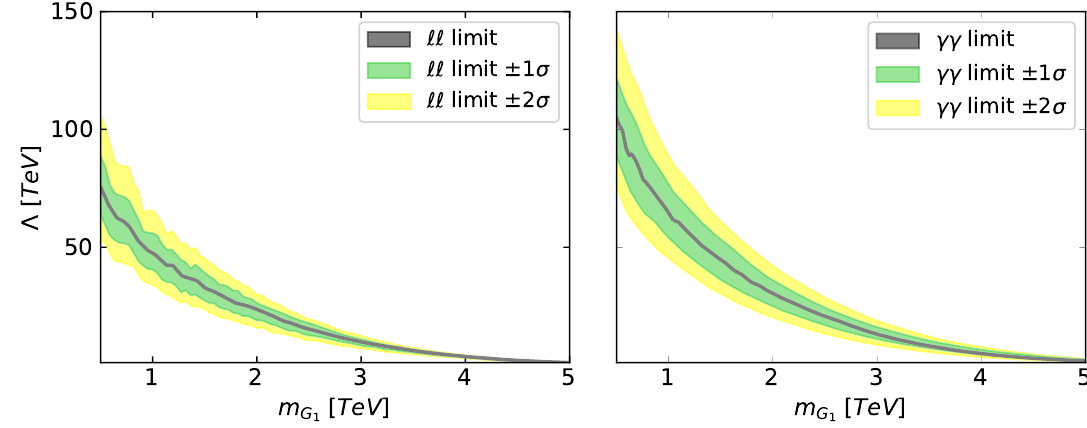
p Figure 8 . Bounds over (cid:3) as a function of m s = 13 TeV and 36 fm (cid:0) 1 , from G 1 from the LHC with refs. [47] and [48]. Red and blue lines represent the 1 (cid:27) and 2 (cid:27) error on the constraint, respectively. The resonance (to be understood as the (cid:12)rst KK-graviton mode) eventually decays into leptons (left panel) or into photons (right